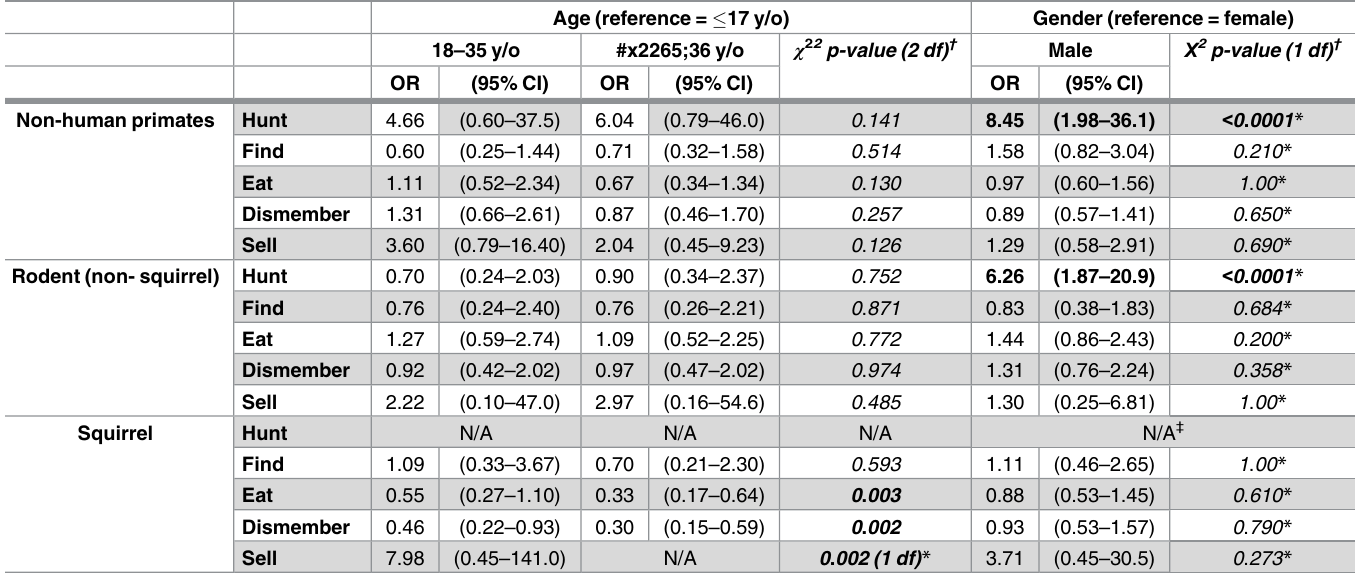
Table 4. Associations of presumptive risk factors for MPXV infection and